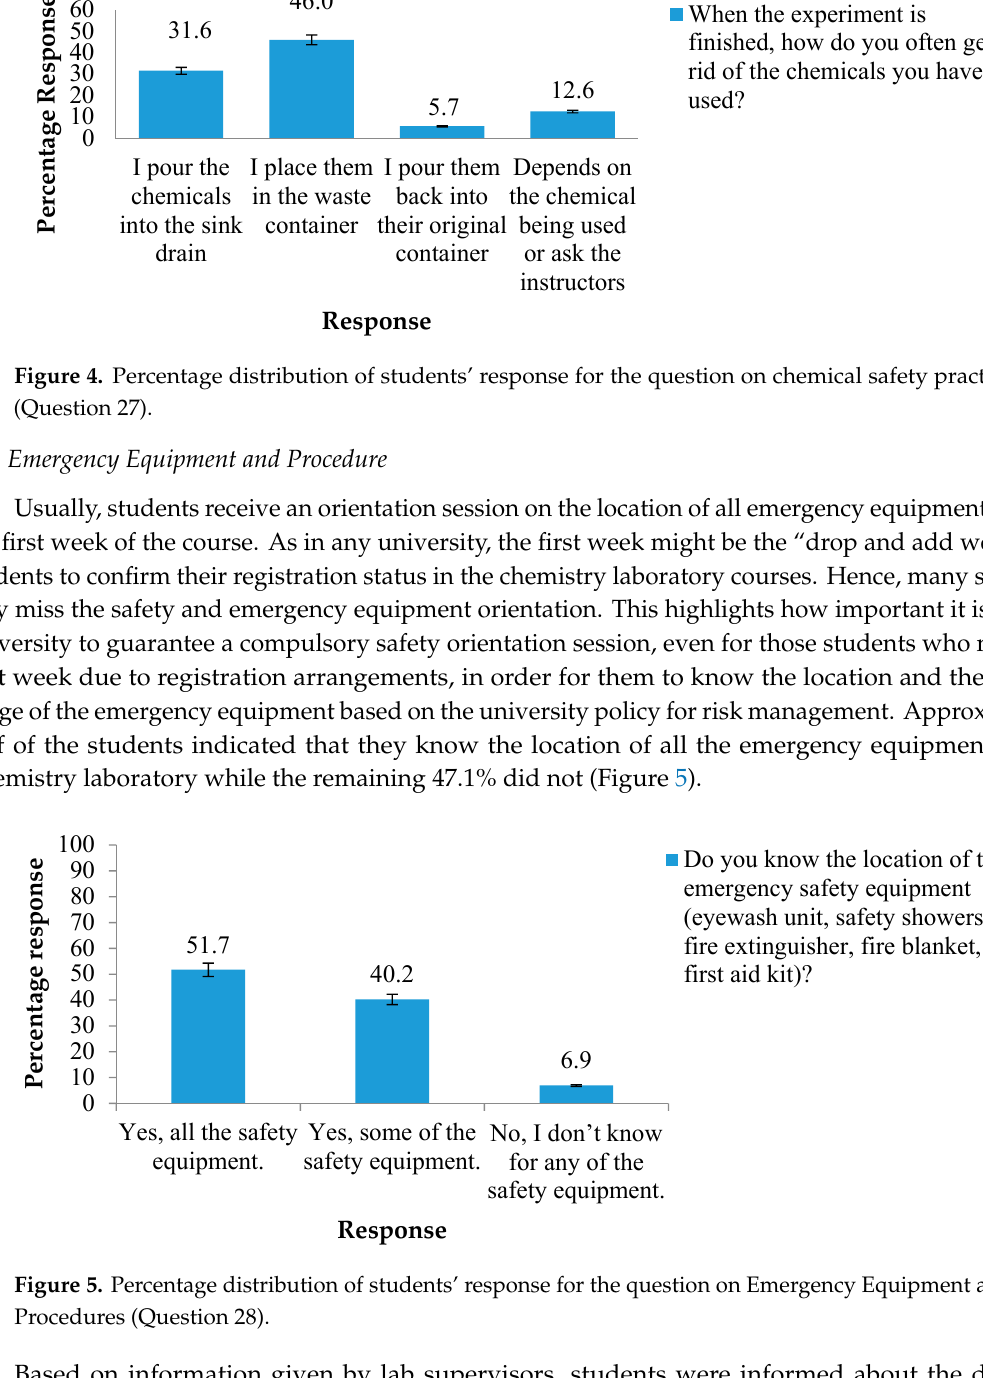
and Procedures (Question 28).